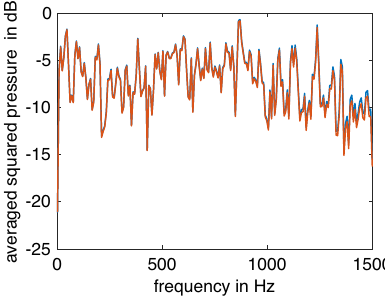
Figure 22. Averaged squared pressure on the half sphere for the original vibration pattern (solid gray line) and the recon- structed vibration pattern (dashed black line).